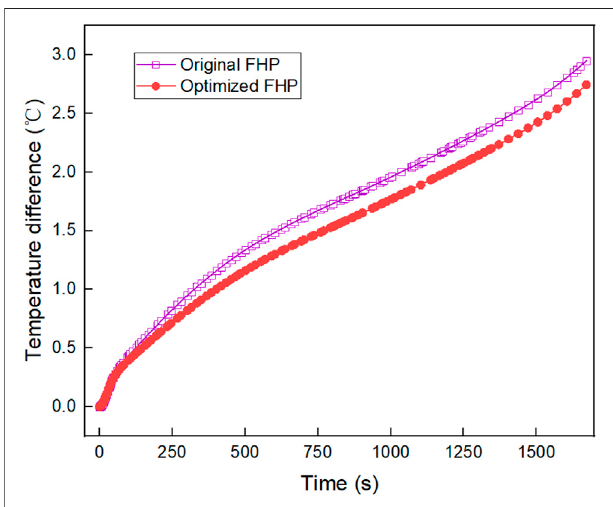
FIGURE 18 | Comparison on Δ Tmax between the original FHP and the optimized